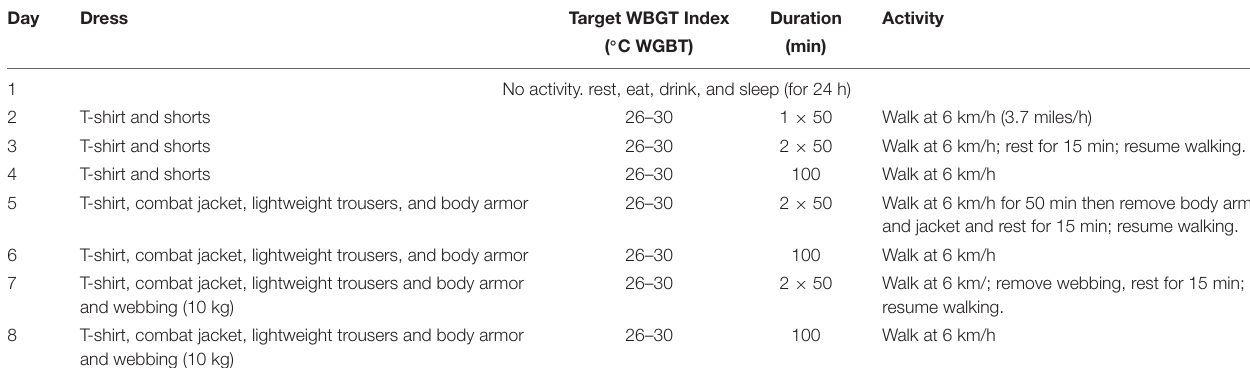
safe initial induction of heat adaptation, whatever the